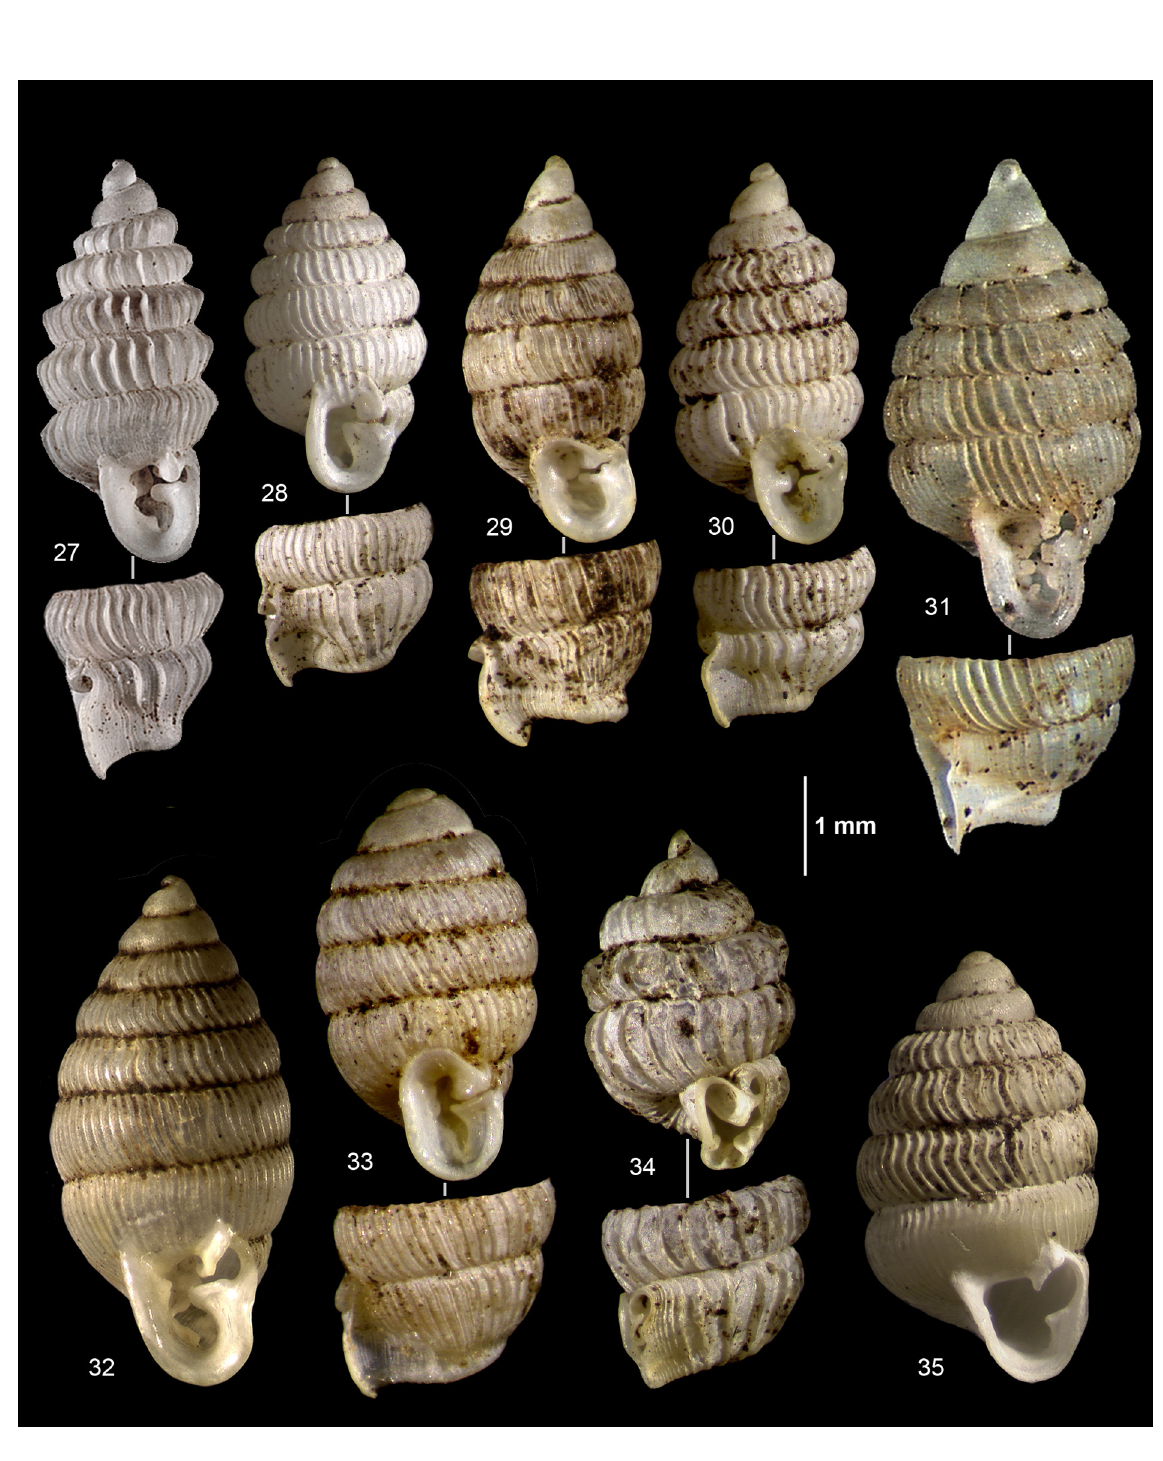
Figs 27-35. Adult shells of Dadagulella gen. nov. species. 27. D. delgada (Muratov, 2010) comb. nov., syntype, Cabo Delgado (after Muratov 2010). 28. D. ecclesiola sp. nov., holotype, Kimboza. 29. D. cresswelli sp. nov., holotype, Ngorongoro. 30. D. minareta sp. nov., holotype, Kimboza. 31. D. cuspidata (Verdcourt, 1962) comb. nov., holotype, Shume. 32. D. pembensis sp. nov., holotype, Ngezi. 33. D. nictitans (Rowson & Lange, 2007) comb. nov., holotype, Macha. 34. D. frontierarum sp. nov., holotype, Mtai. 35. D. delta sp. nov., holotype,